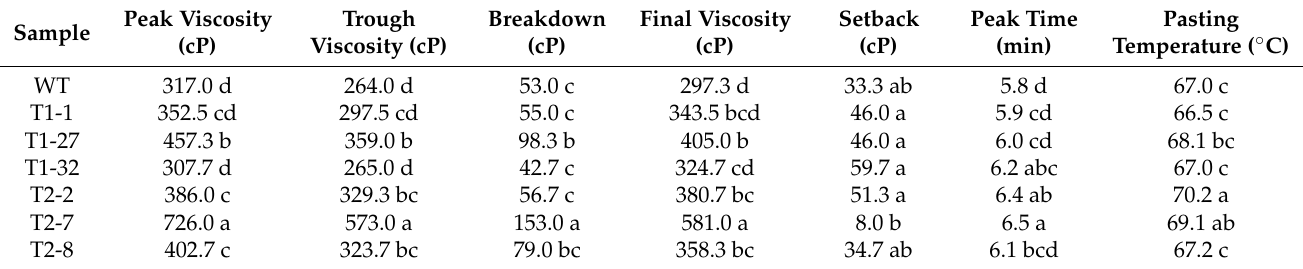
Table 2. Pasting properties of samples from wild-type (WT, Yukon Gold strain TXYG79) and gene edited events. Data represent mean values; n = tubers from three plants, except in case of event T1-1 tubers from only two plants were available; different lower-case letters for each value in the same column indicate a significant difference between plant types; p ≤ 0.05 (Student’s t -test with LS